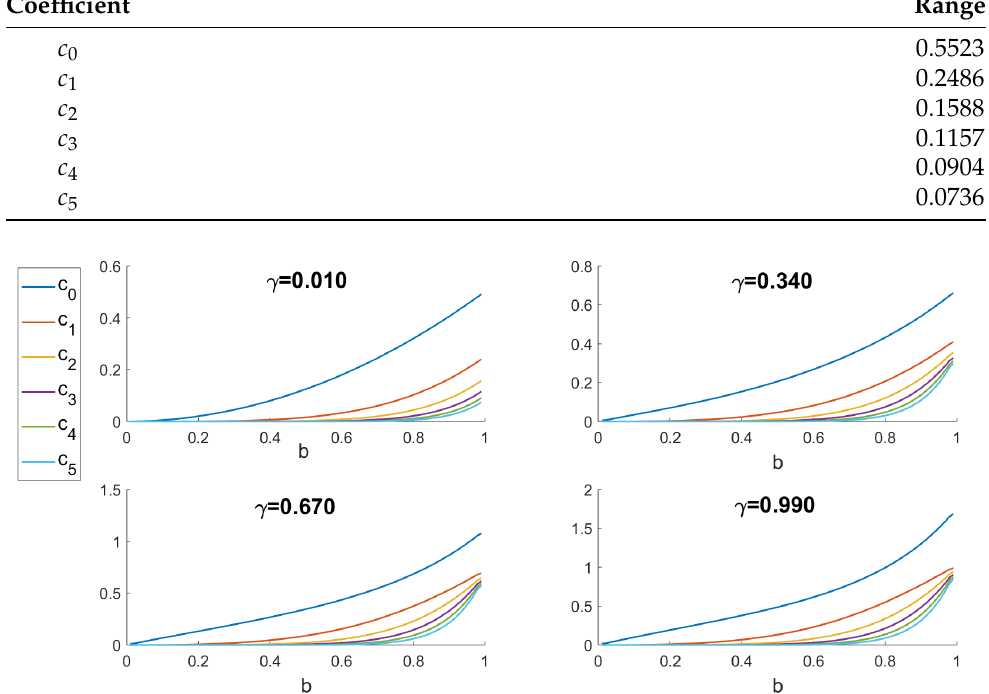
Figure 3. Norm of the gradient of the coefficients c n ( γ , b ) in terms of b ∈ ( 0,1 ) for different values of γ . We can see that the gradients of higher coefficients n ≥ 2 are smaller than those of the first two. We can also observe that these gradients become small for small values of b .